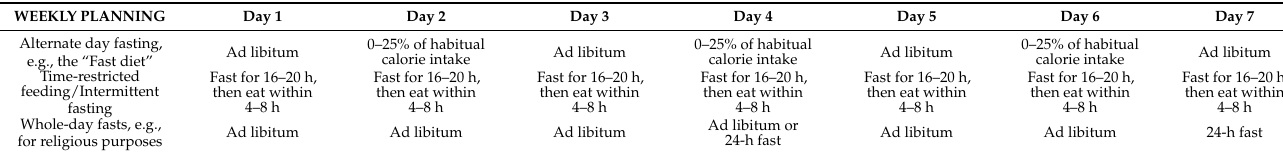
Table 1. Most common types of